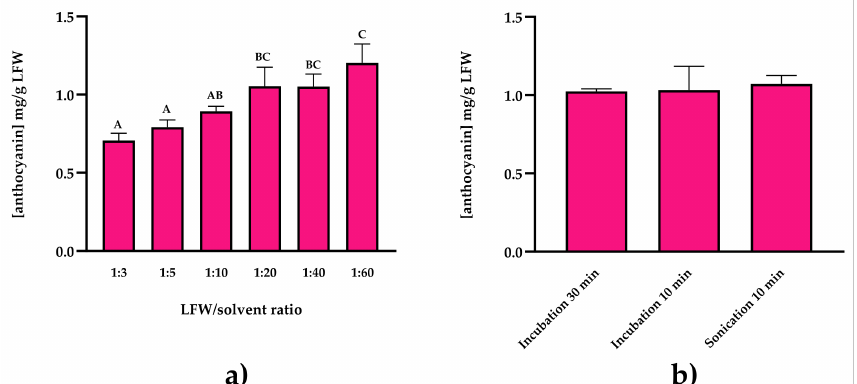
Figure 2. Anthocyanin yields were obtained with ( a ) different ratios of leaf fresh weight (LFW) to solvent volume (g/mL) and ( b ) different solubilization methods. Data are means ± SD ( n = 3 independent experiments; one-way ANOVA with Tukey’s post hoc test, p < 0.05, significant differences are indicated by different